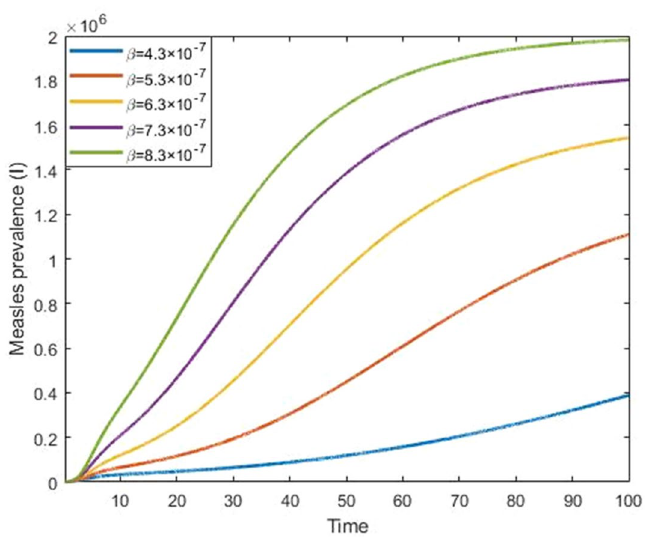
Figure 10. Impact of transmission rate ( β ) on measles